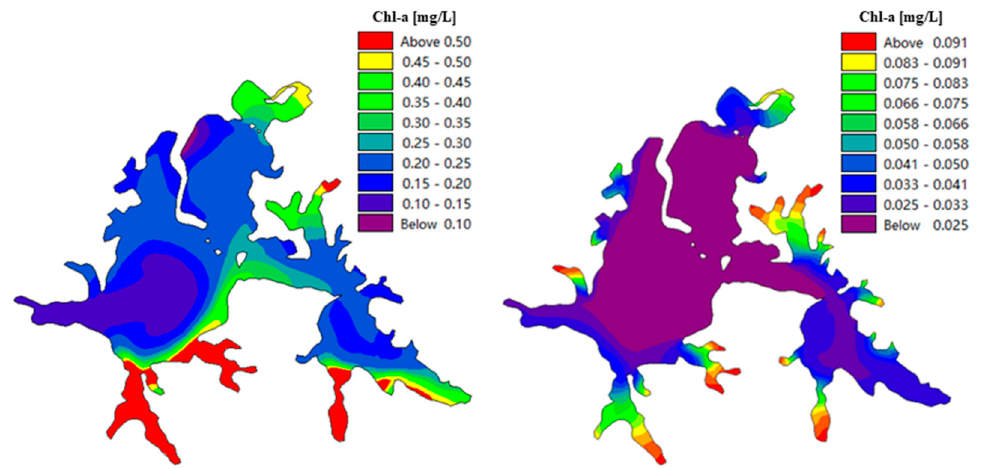
Figure 10. Comparison of chlorophyll a simulation results before (left) and after (right) parameter